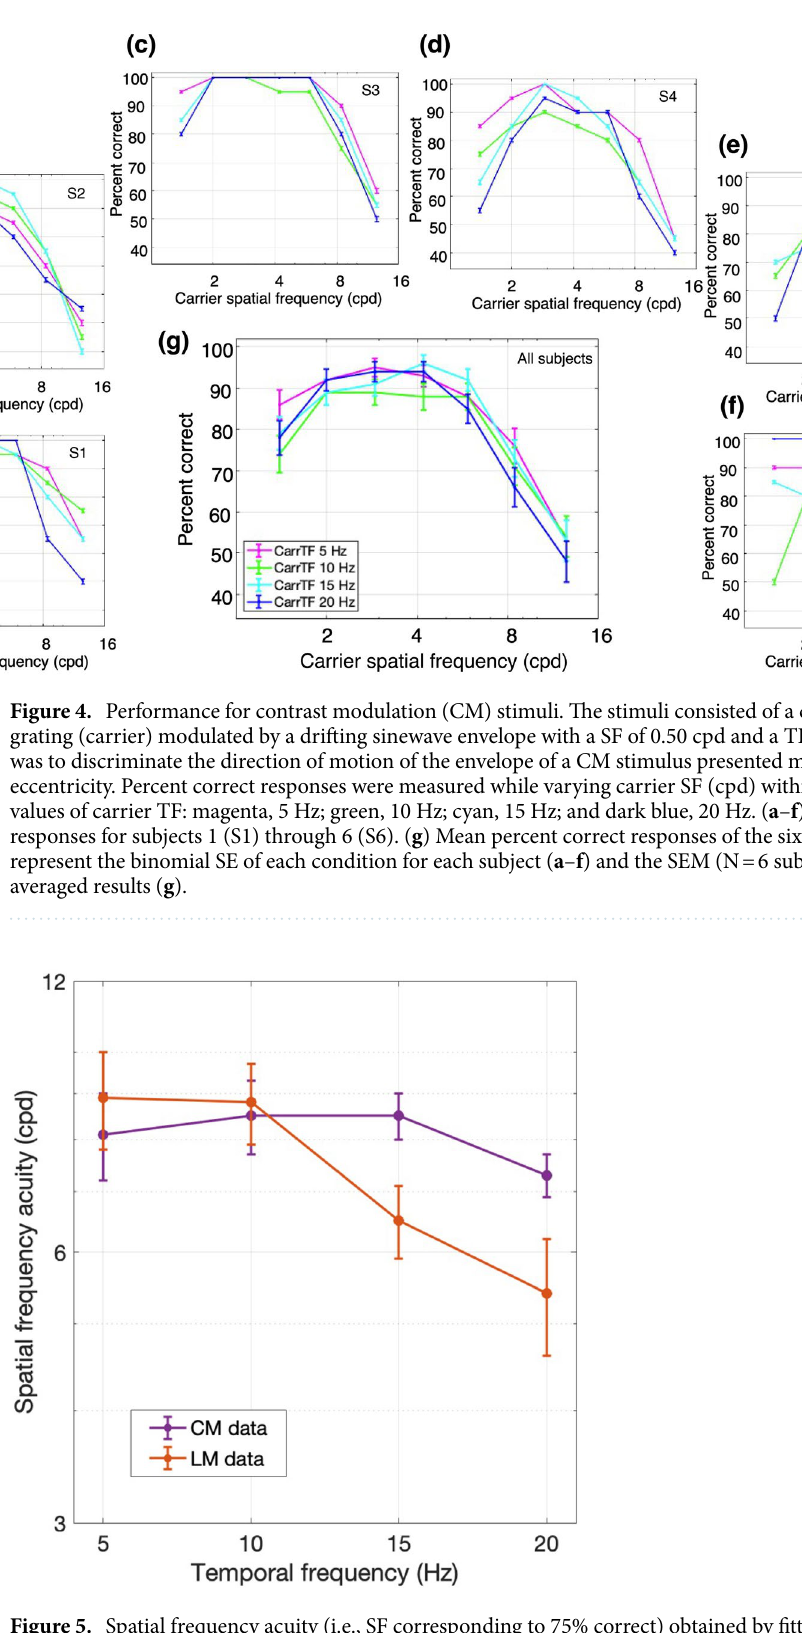
Figure 5. Spatial frequency acuity (i.e., SF corresponding to 75% correct) obtained by fitting the high-SF fall-off of the individual subject data in Figs. 3 and 4 for LM (orange) and CM (purple) stimuli, respectively. Error bars indicate ± SEM (N = 6